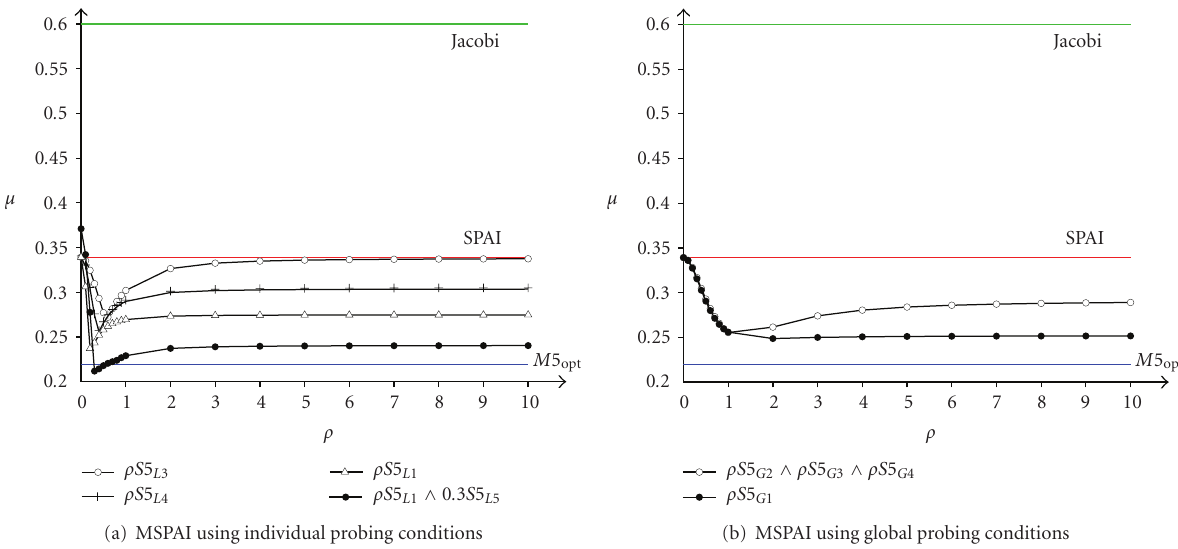
Figure 2: Smoothing factor μ against subspace weight ρ . MSPAI using individual (a) and global (b) probing conditions compared to Jacobi, SPAI, and M 5 opt (26) for the 2D constant-coe ffi cient model problem A 2 of size n = 1024. Table 2: Smoothing factors by using M 9 opt (37), SPAI, and MSPAI with local probing conditions for the 2D 9-point stencil A 3 of order n = 1024. M 9